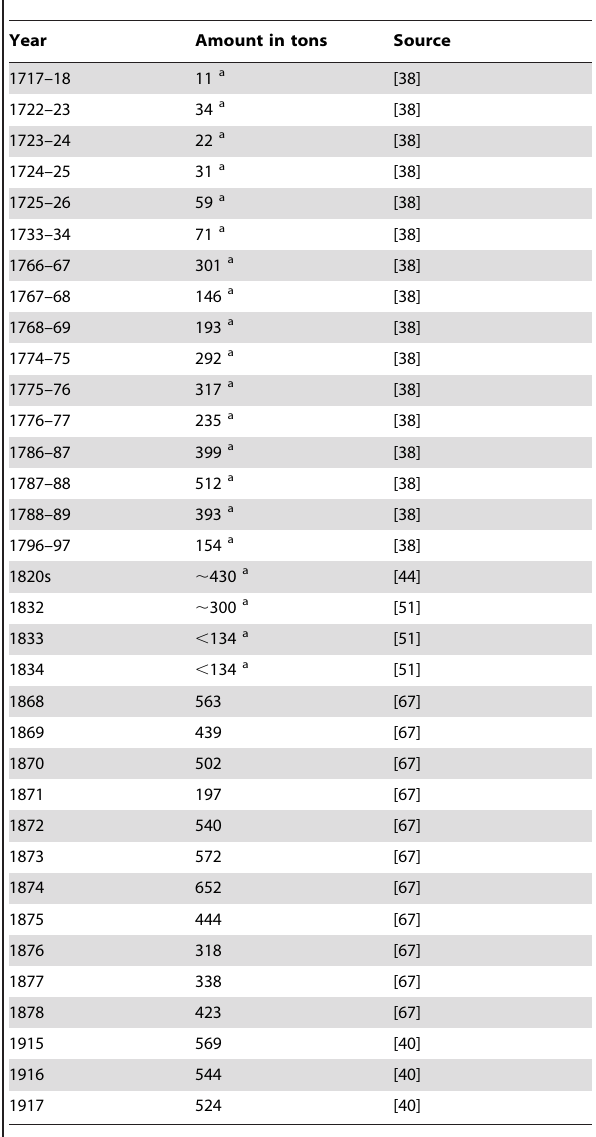
Table 1. Annual trepang exports from Makassar